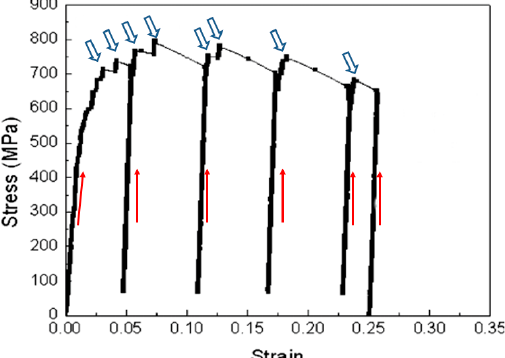
Figure 2. Indication of strain bursts on a stress-strain curve obtained from the compression test of a single crystal <001>-oriented Au pillar. The hollow arrows indicate the occurrence of the stress drop. The plastic flow between two neighboring hollow arrows is discontinuous. The red solid arrows indicated the increase of the load [3] ( Reprinted from Acta Materialia, Copyright 2005, with permission from Elsevier